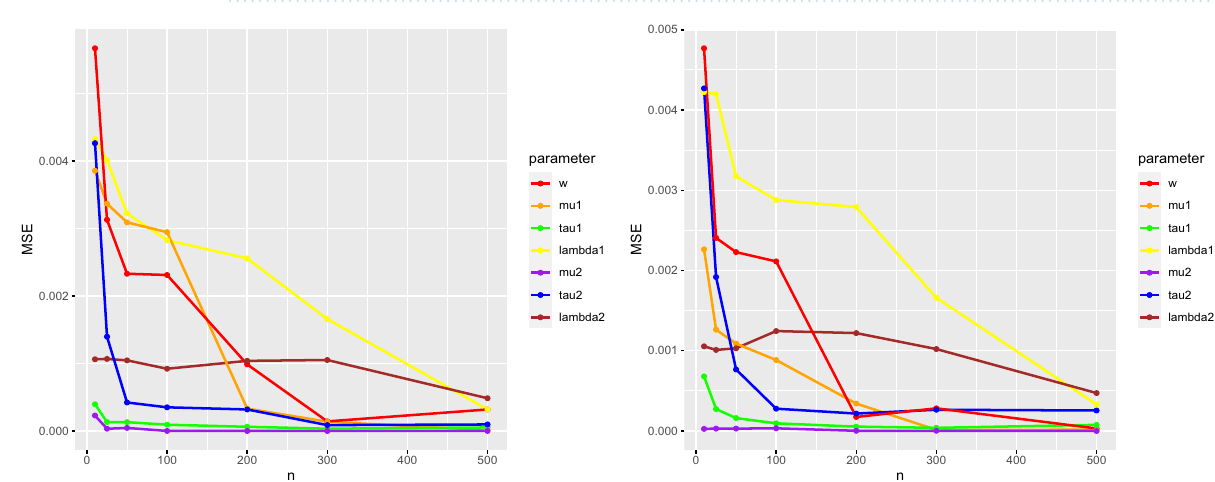
Figure 7. MSE of Bayes estimates under the squared error (left) and absolute error (right) loss functions, for n = 10, 25, 50, 100, 200, 300, 500